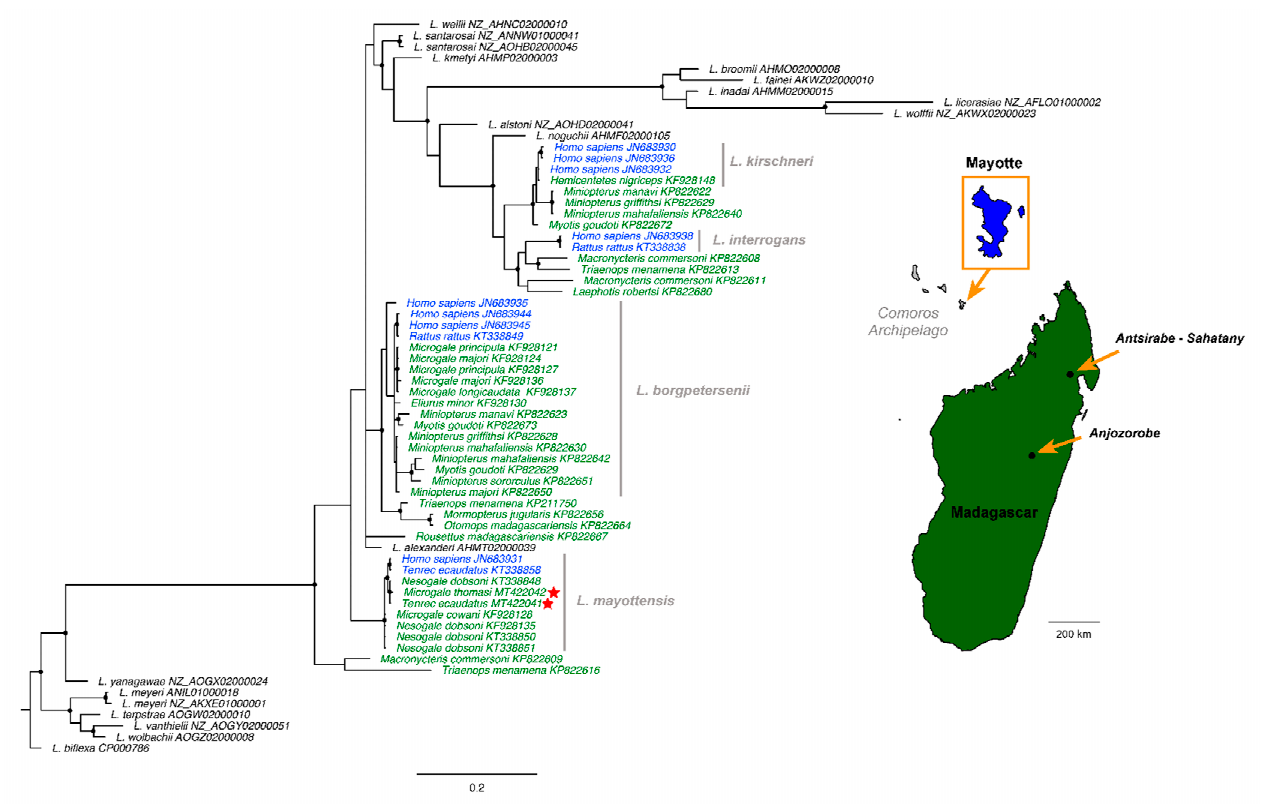
Figure 1. Geographical context and Bayesian phylogenetic tree of Leptospira species from Mayotte (blue) and Madagascar (green) based on secY gene (482 bp). Sequences in black correspond to Leptospira species used as ingroups and outgroup ( L. biflexa ). The accession number is indicated for each sequence. The analysis was conducted under the HKY + I + G substitution model. Black circles at the nodes indicate posterior probabilities superior or equal to 0.90. The red stars indicate new sequences generated in the present study and were obtained from two regions on Madagascar: Anjozorobe and Makira (Commune Antsirabe-Sahatany). The map was realized using worldHires function in mapdata package [27] under the R software version 4.1.1.